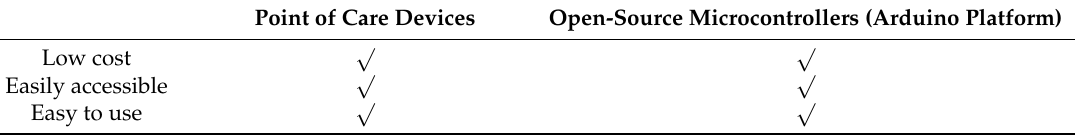
Table 1. Common properties of open source microcontroller platforms and PoC